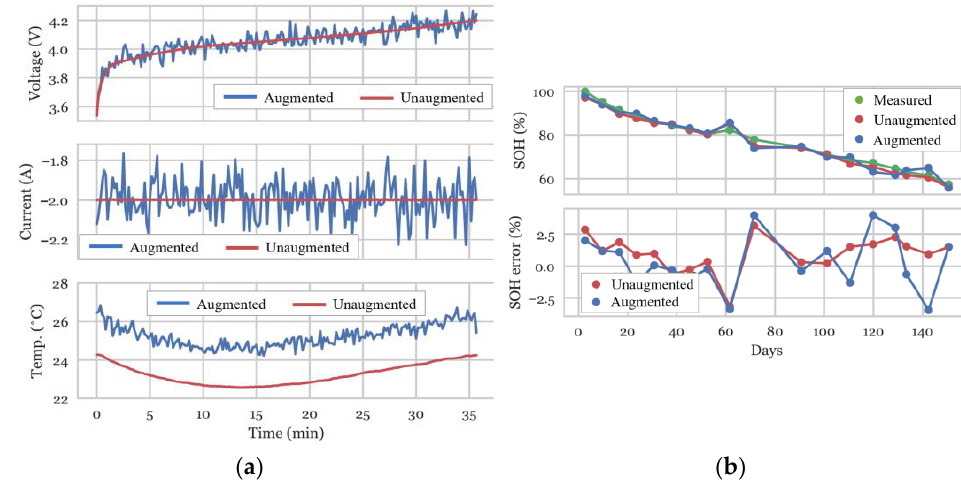
Table 4. Results showing effect of augmented versus unaugmented validation dataset. Validation Data Augmentation Figure 5. ( a ) Estimation accuracy over validation data versus number of layers in CNN. ( b ) Estimation accuracy measured during validation versus number of training datasets. All tests were performed over validation datasets recorded at 25 °C.